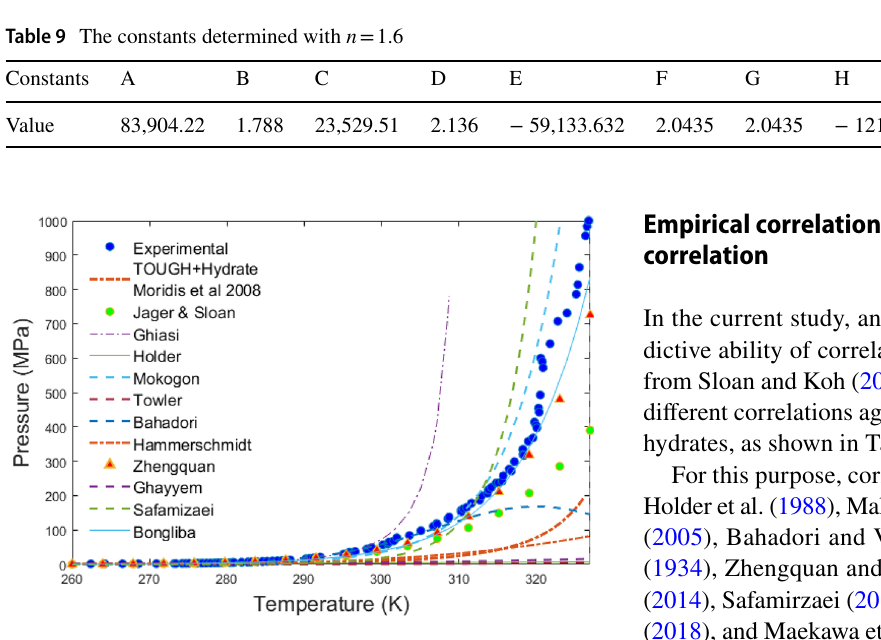
Fig. 13 Peq versus T plot showing comparison of experimental data (CH 4 hydrates) for different